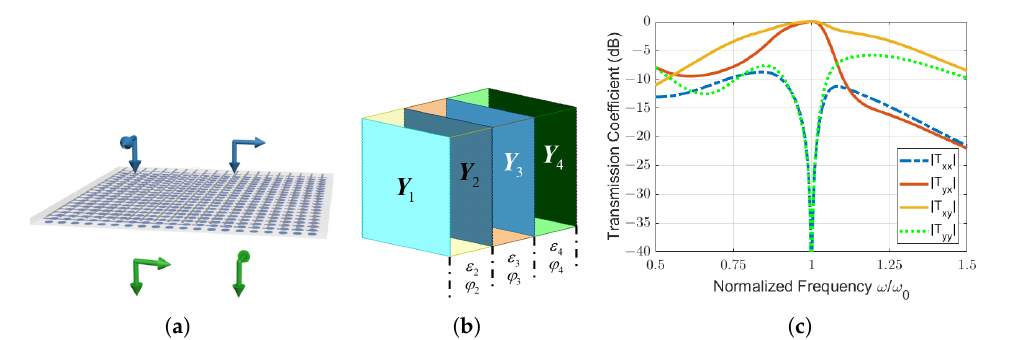
Figure 13. A linear polarization rotator. ( a ) Polarization-converting operation of the metasurface [23]. ( b ) Unit cell of the polarization rotator. ( c ) Simulated transmission